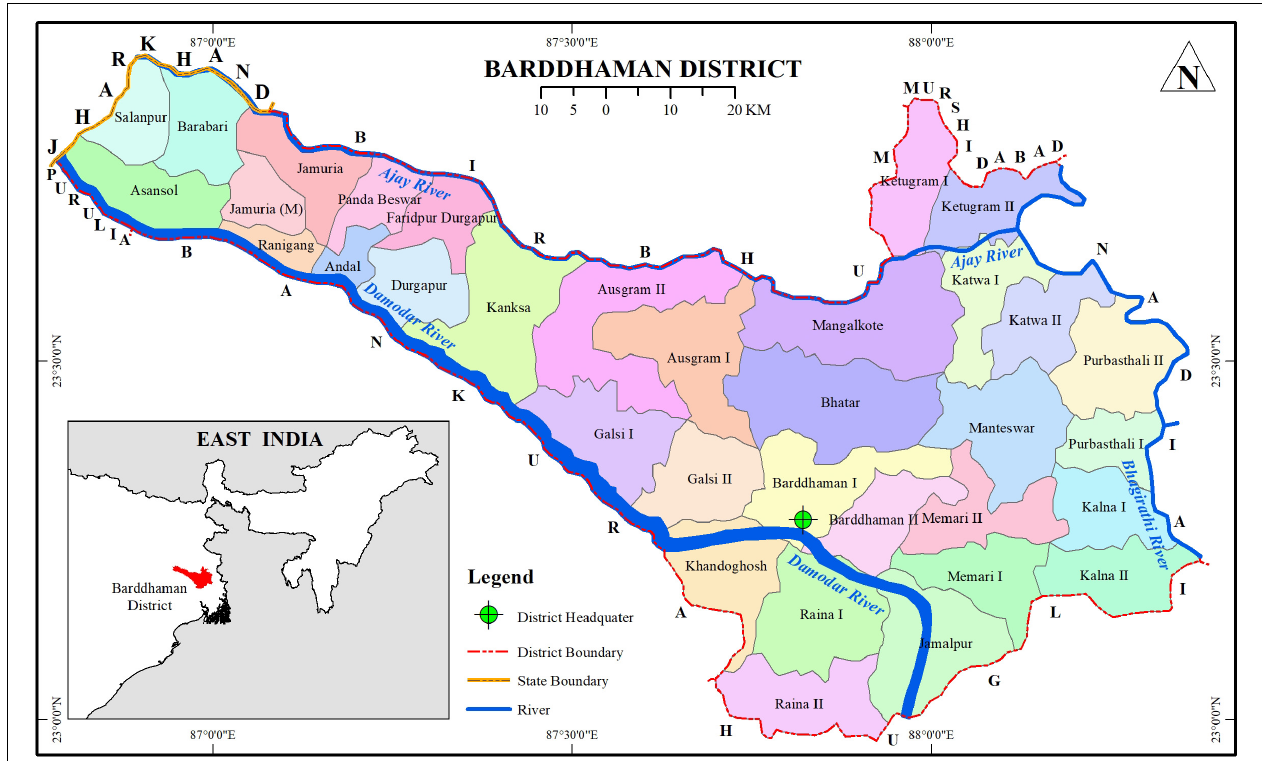
FIGURE 1 | Locational and administrative map of Bardhhaman district. Source: Survey of India and the National Informatics Centre (NIC), 2017.